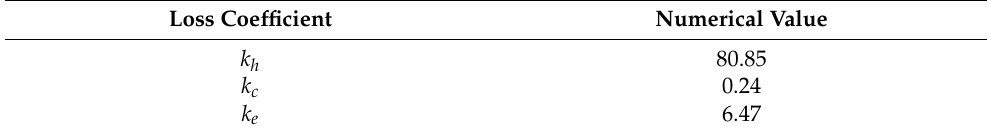
Figure 5. Experimental device diagram of air compressor motor.